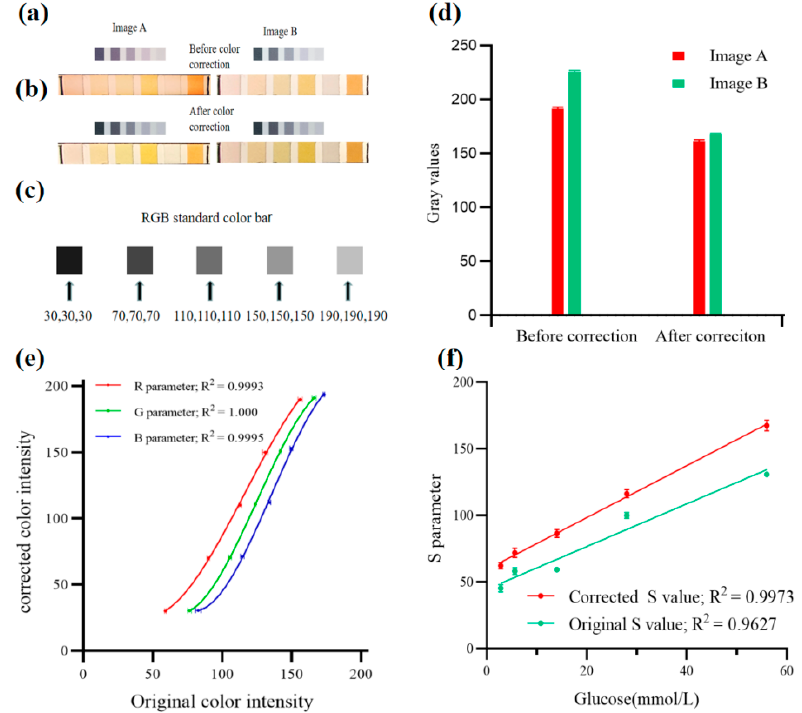
Figure 2. Principle of color correction using a standard color bar. ( a ) The photographs taken at 1247 lux and 326 lux showed obvious differences in color. ( b ) After color correction, no obvious difference can be observed. ( c ) Standard color bar used for color calibration. ( d ) Color intensity of the strip before and after color correction. ( e ) Three color calibration curves for R, G, and B parameters were established. Error bars show the standard derivation ( n = 3). ( f ) The standard curve of glucose before and after color correction.